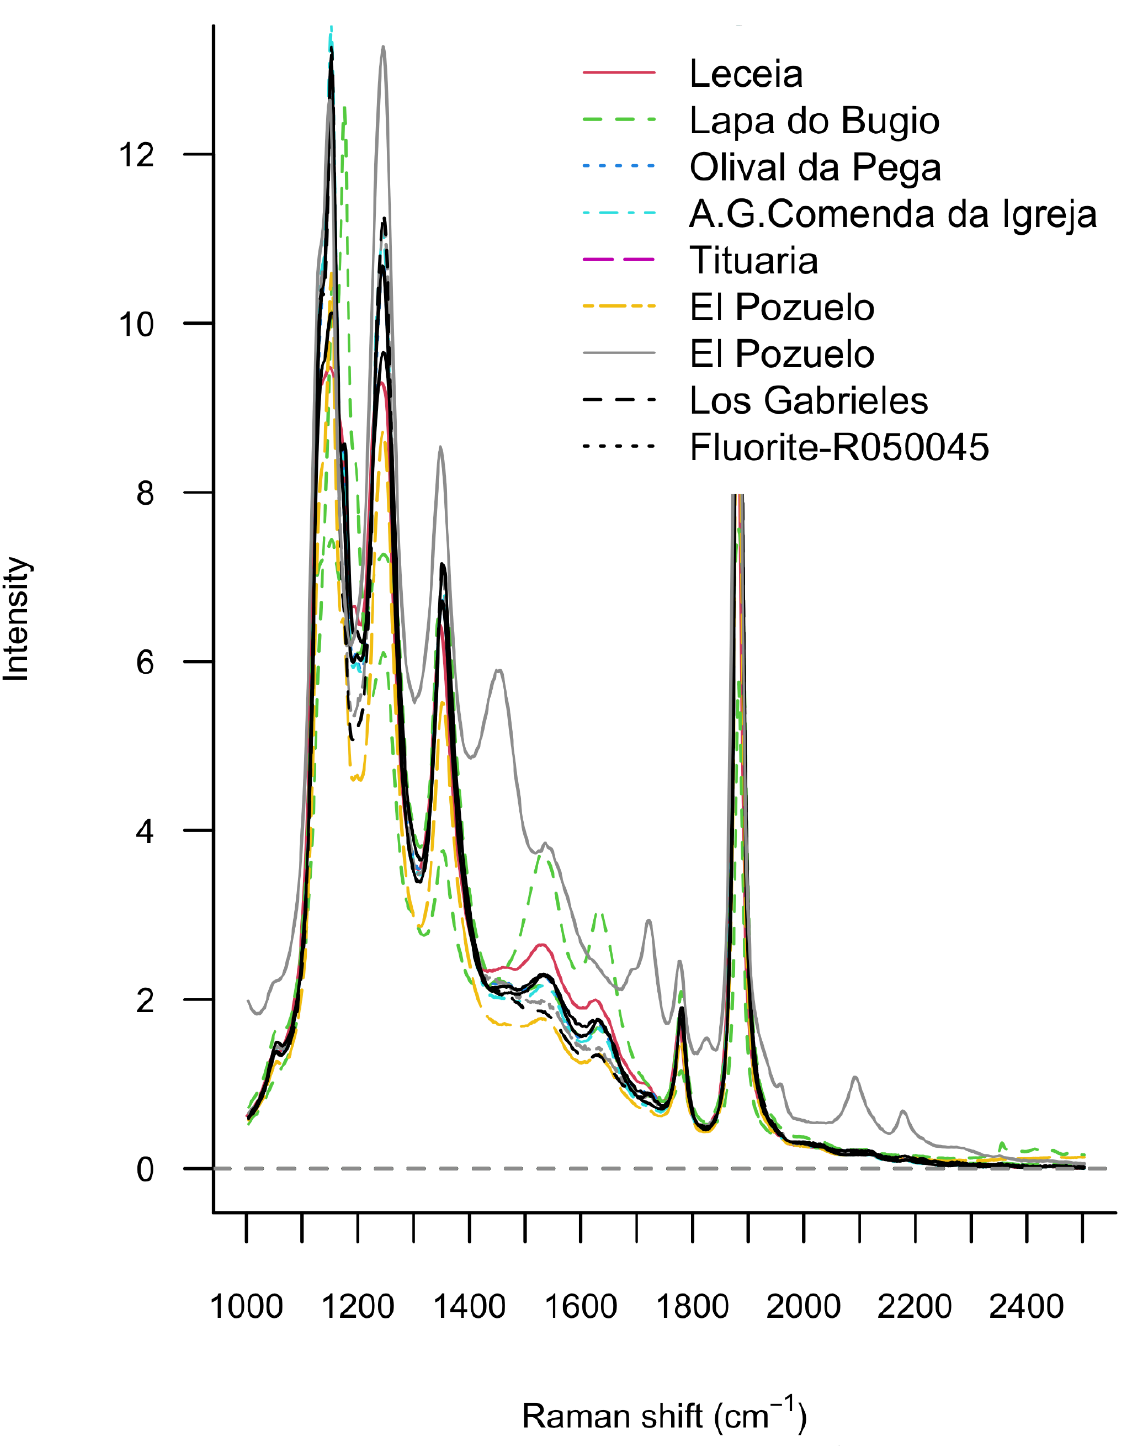
Figure 5. Raman spectra in the frequency-shift region between 1000 and 2500 cm -1 showing the typical fluorite PL spectra lacking the T 2g Raman